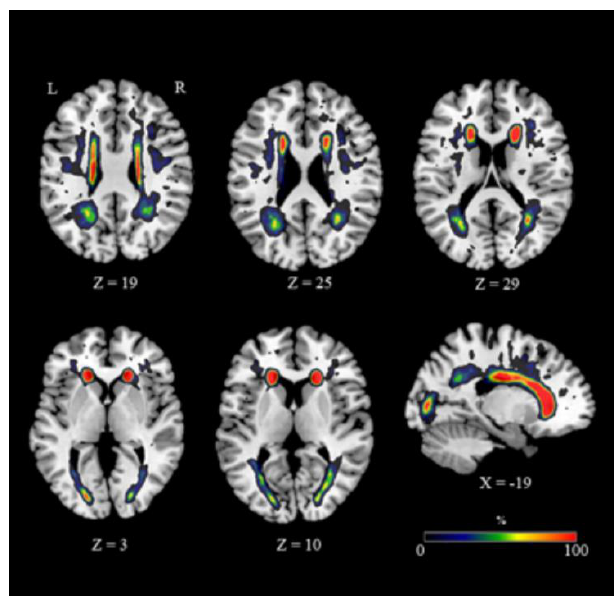
Legend: R, right; L, left; Coordinates are in Montreal Neurological Institute (MNI) space. Figure 1. WMH distribution. Representative slices showing an overlapping of WMH maps. The color bar indicates the percentage of subjects overlapping obtained for each voxel. Table 4. White matter hyperintensities volume (in mm 3 ) and distribution in the WMH + group. Participant Periventricular WMH Volume